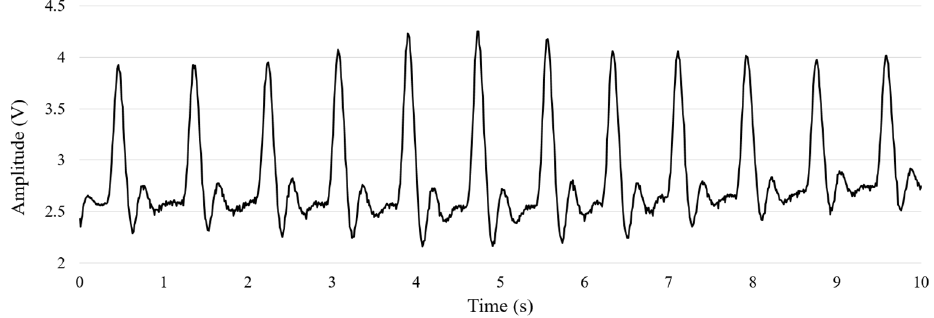
Figure 2. Sample of original PPG signal obtained from a pulse sensor.